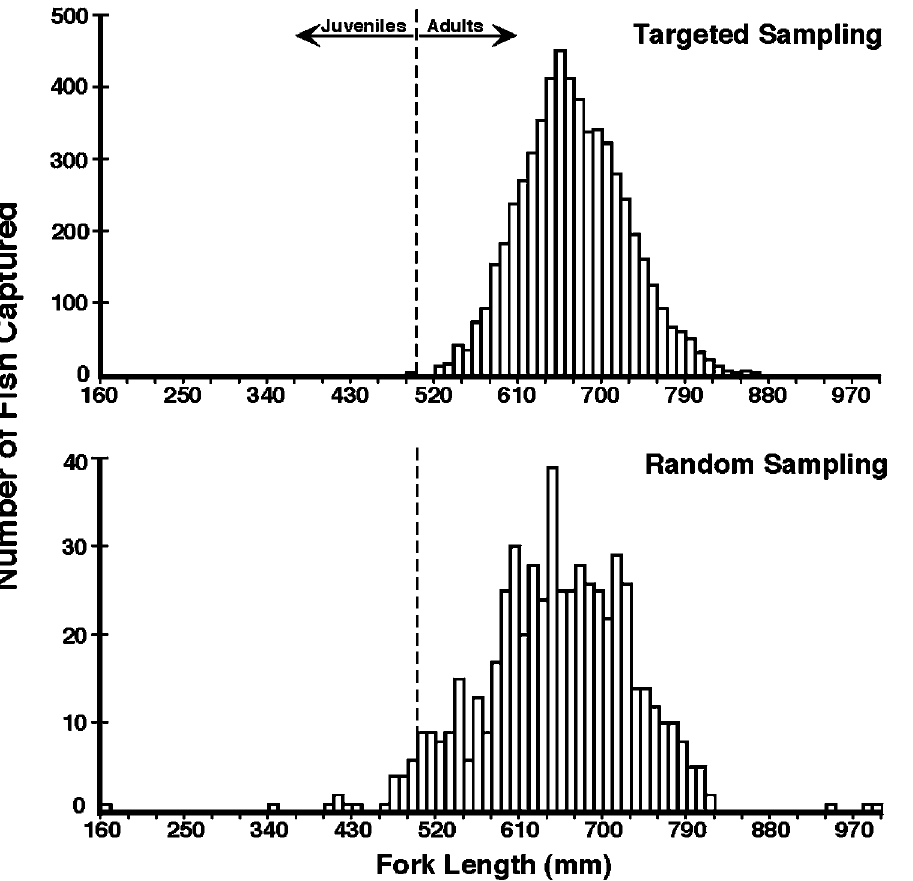
Figure 2. Size distribution of adult shortnose sturgeon captured in targeted sampling in spawning and adult wintering habitats, and the size distribution of shortnose sturgeon captured in random sampling during summer. Shortnose sturgeon greater than 50 cm fork length (FL) were classified as adults. During summer sampling, all life stages of shortnose sturgeon are well distributed in the river system. doi:10.1371/journal.pone.0000168.g002 (Jolly-Seber method) varied in results as expected for this method population sizes centered on 59,545 with modest variation [26] with initial and ending estimates in the series showing high (coefficient of variation 27 to 30%). Findings using the open variance. A mid-series set of three estimates had consistent results: population estimates were not different than those using the closed